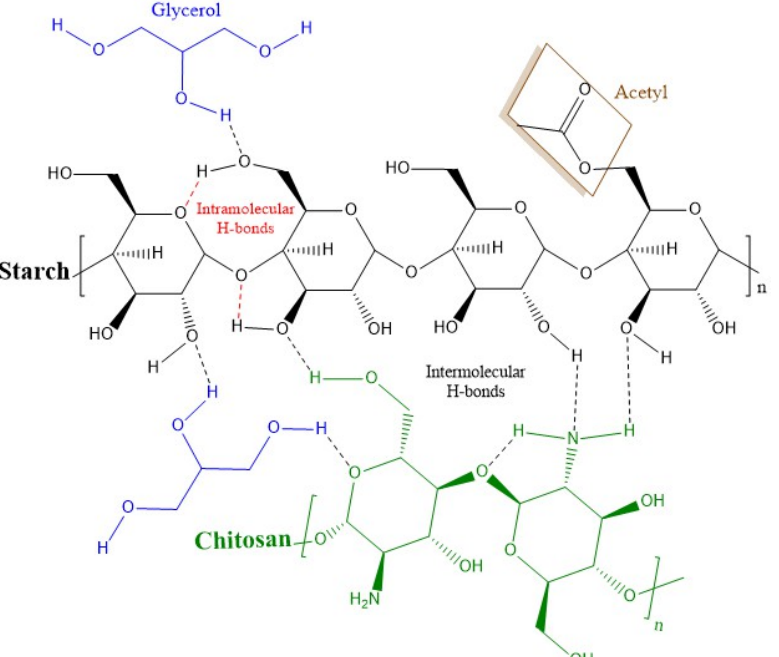
Figure 2. Proposed molecular interactions between starch, chitosan, and glycerol.